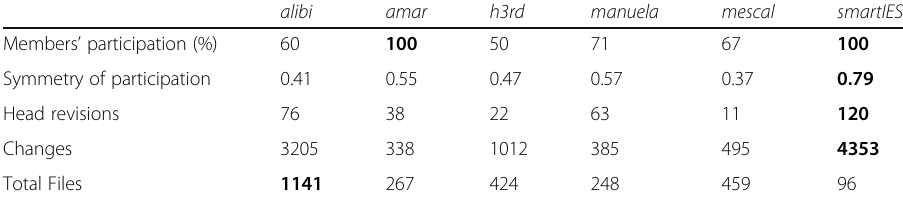
Table 1 Statistics of groups ’ activity as captured by the project management platform alibi amar h3rd manuela Members ’ participation